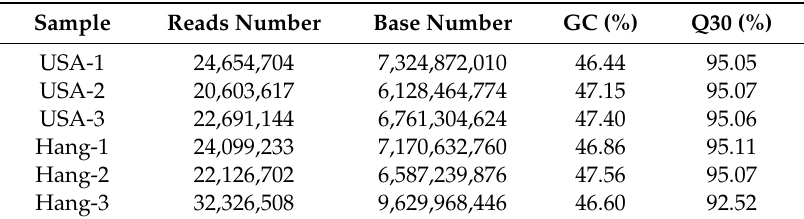
Table 1. Sequencing data output statistics.